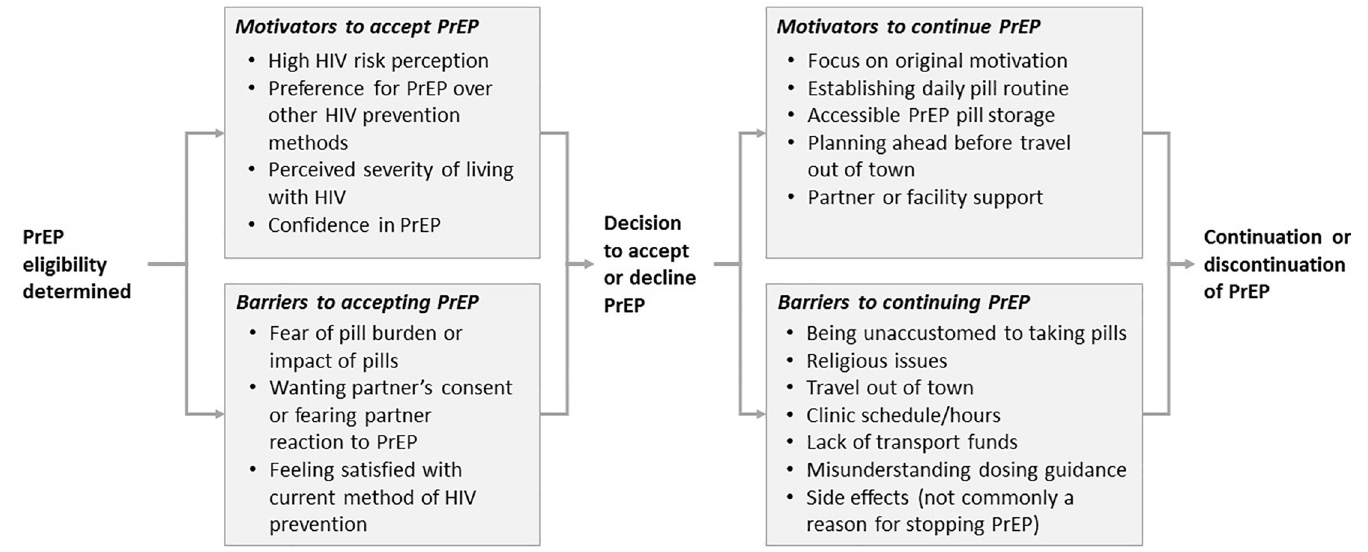
Fig 2. Key factors motivating PrEP uptake and